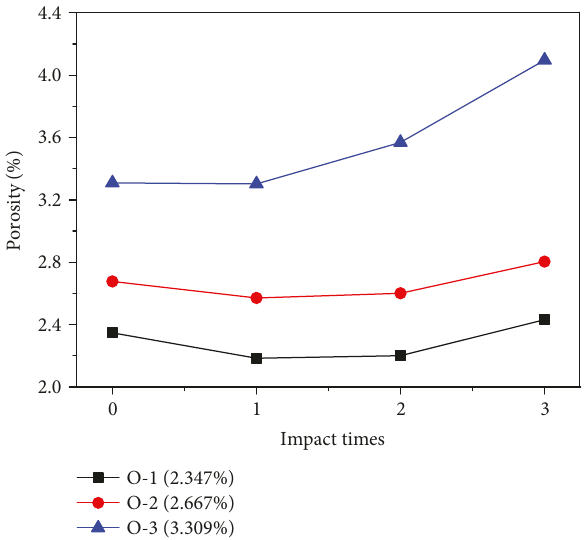
Figure 11: The relationship between e ff ective porosity and impact times.